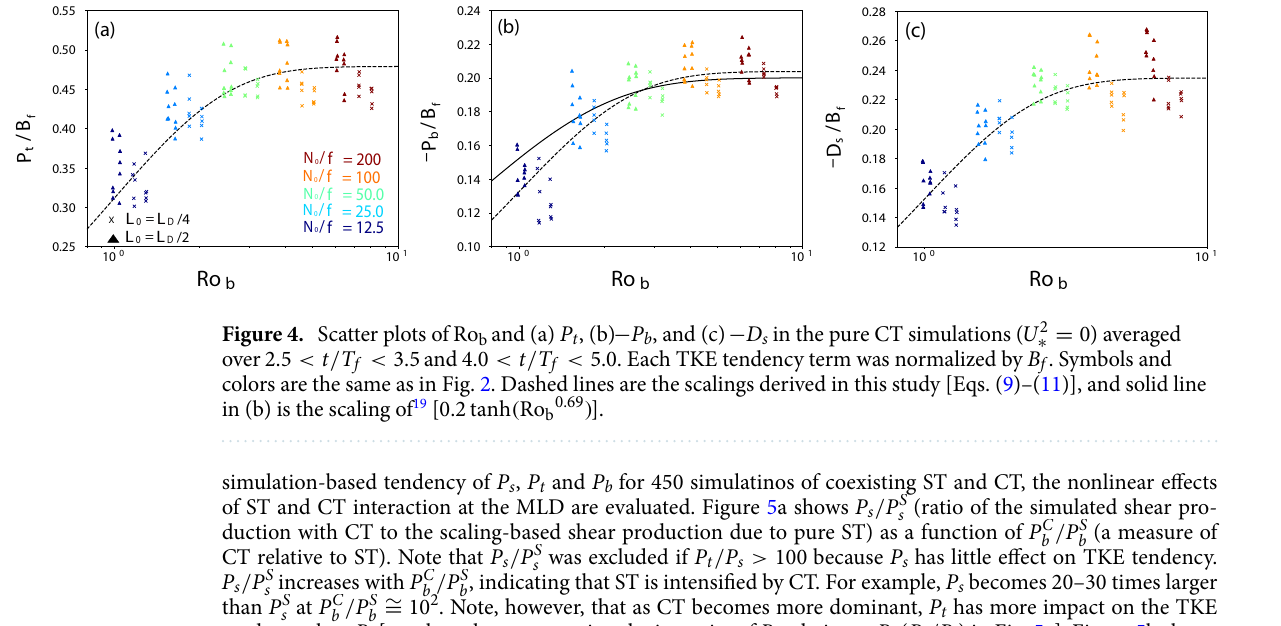
Figure 4. Scatter plots of Ro b and (a) P t , (b) over 2.5 < t / T f < 3.5 and 4.0 < t / T f < 5.0 . Each TKE tendency term was normalized by B f . Symbols and colors are the same as in Fig. 2. Dashed lines are the scalings derived in this study [Eqs. (9)–(11)], and solid line in (b) is the scaling of 19 [ 0.2tanh ( Ro b0.69 )